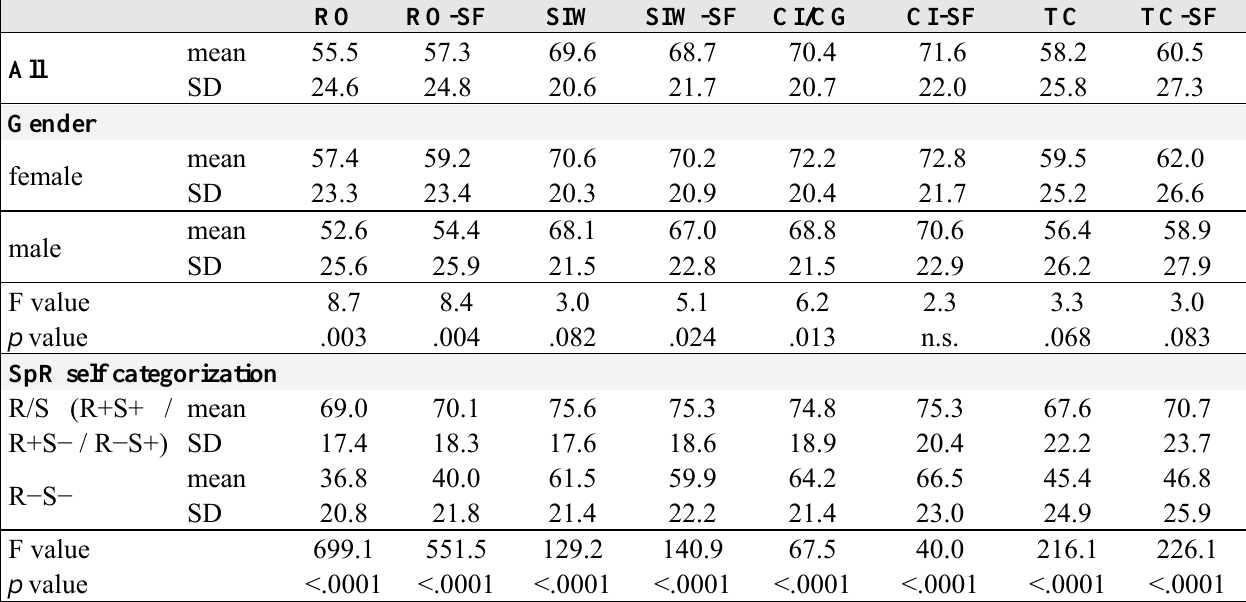
Table 7. Mean values within the Polish sample (n =